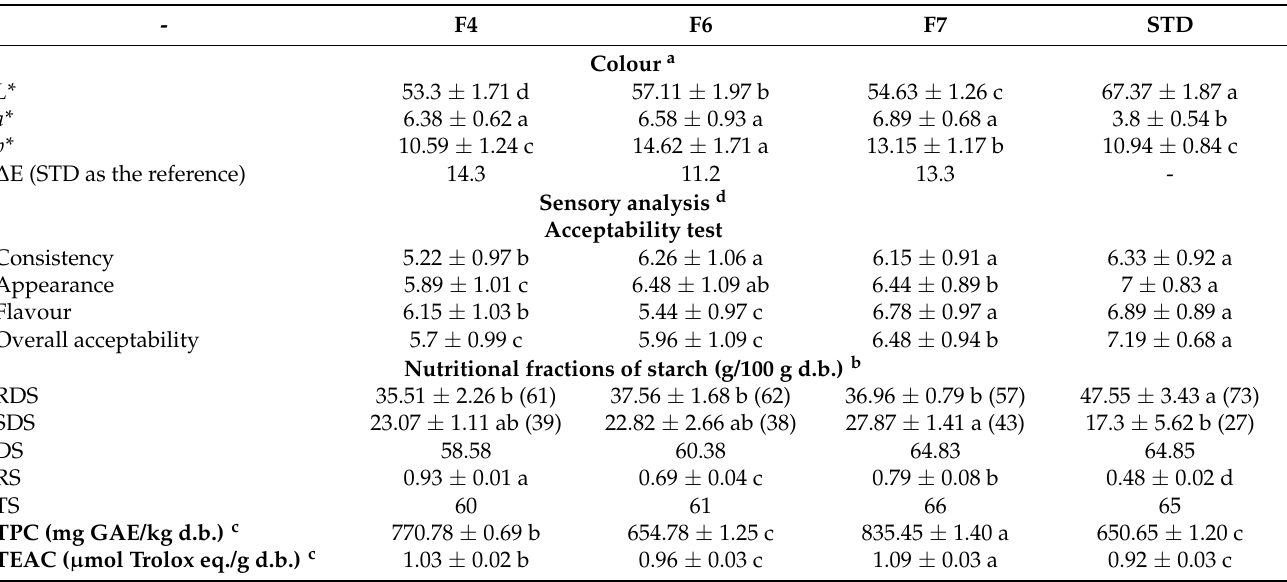
Table 5. Colour, sensory, and nutritional properties of flatbreads. In brackets, the percentage of RDS or SDS calculated in the DS is